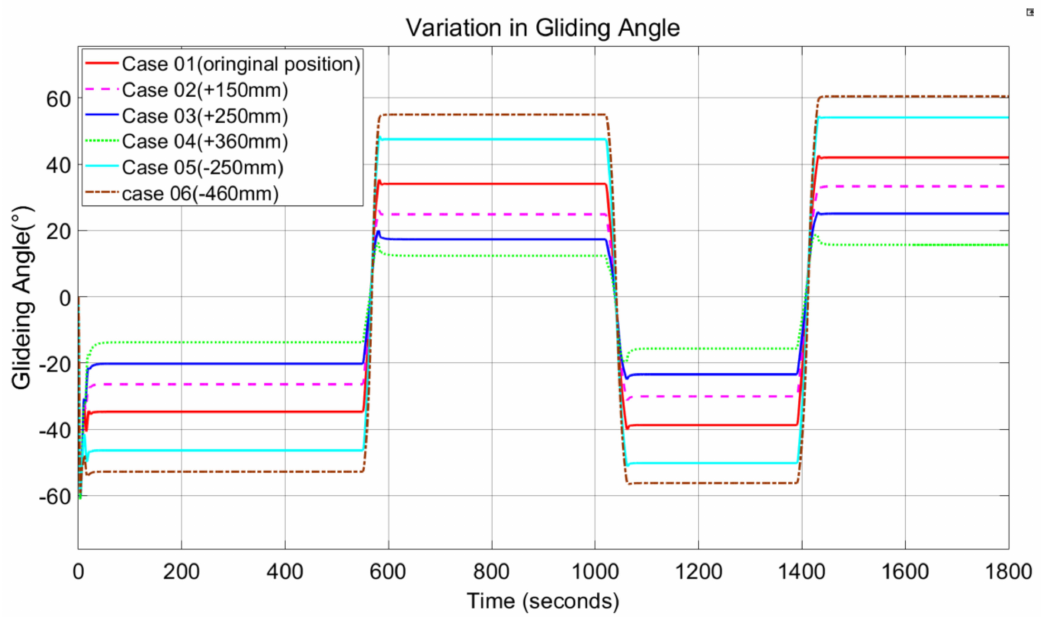
Figure 14. Simulation results of the gliding